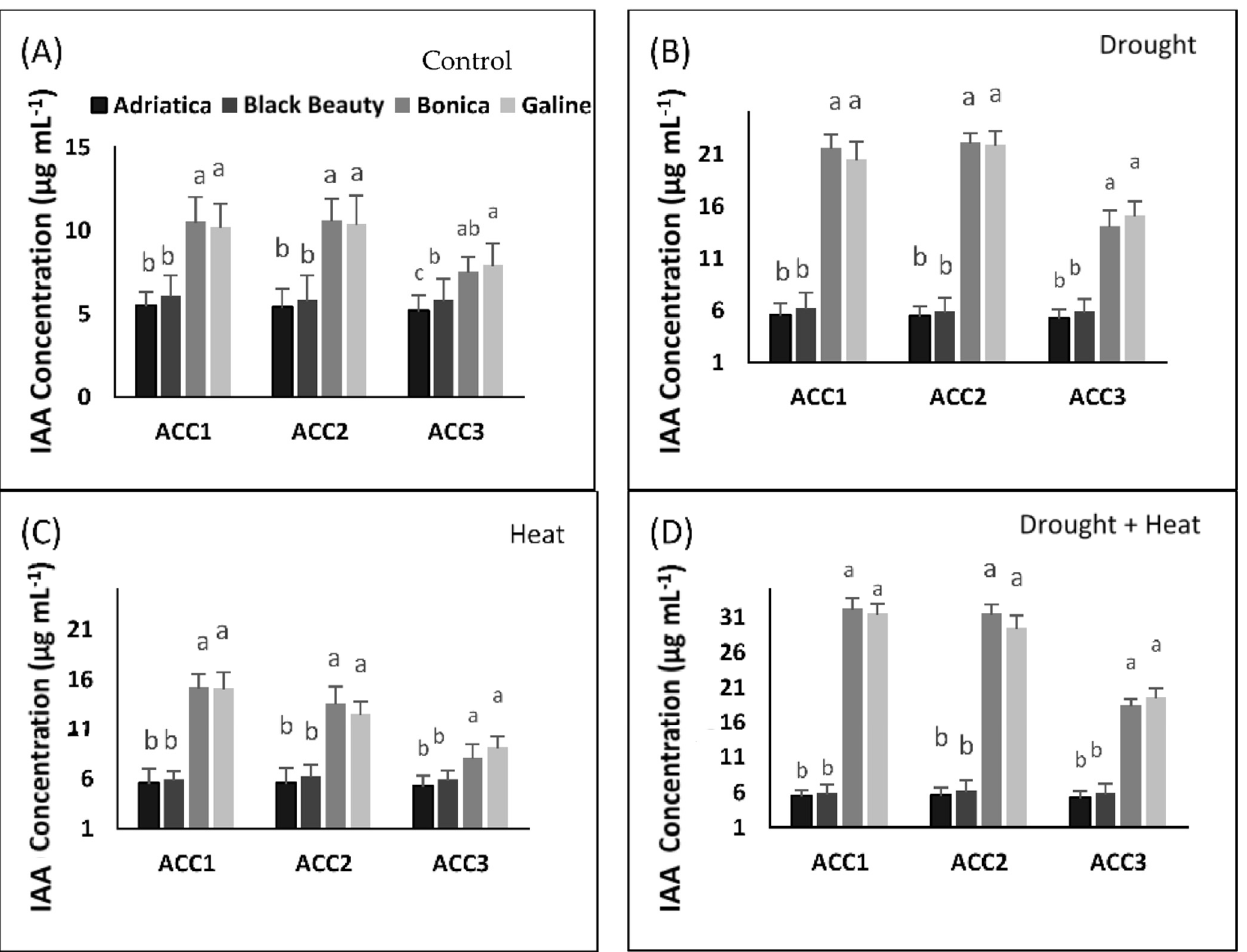
Figure 10. Estimation of IAA production (nmol α -ketobutyrate mg protein − 1 h − 1 ) in response to individual and combined stresses of four isolates from four eggplant cultivars’ roots: ( A ) (Control), ( B ) (Drought), ( C ) (Heat), and ( D ) (Drought + Heat). The values are means of five repetitions ± SE ( n = 5). Significant dissimilarities are shown by different lower-case letters between treatments ( p < 0.05) based on Tukey’s HSD test.